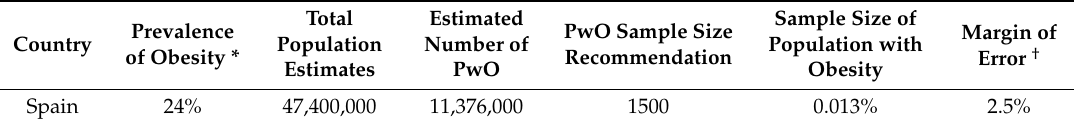
Table 1. Sample size considerations for the Spanish cohort of the Awareness, Care and Treatment in Obesity Management—An International Observation (ACTION-IO)